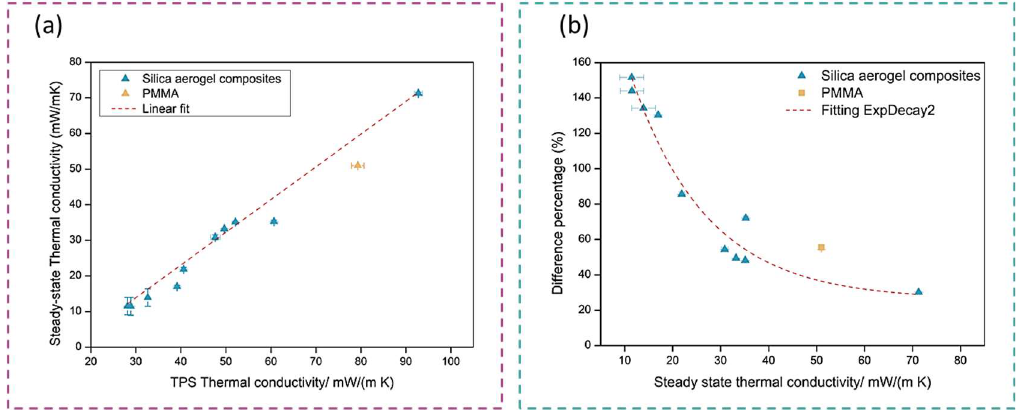
Figure 3. ( a ) Correlation between steady-state and TPS thermal conductivity experimental values; ( b ) difference percentage between TPS and steady-state methods as a function of the thermal conductivity.